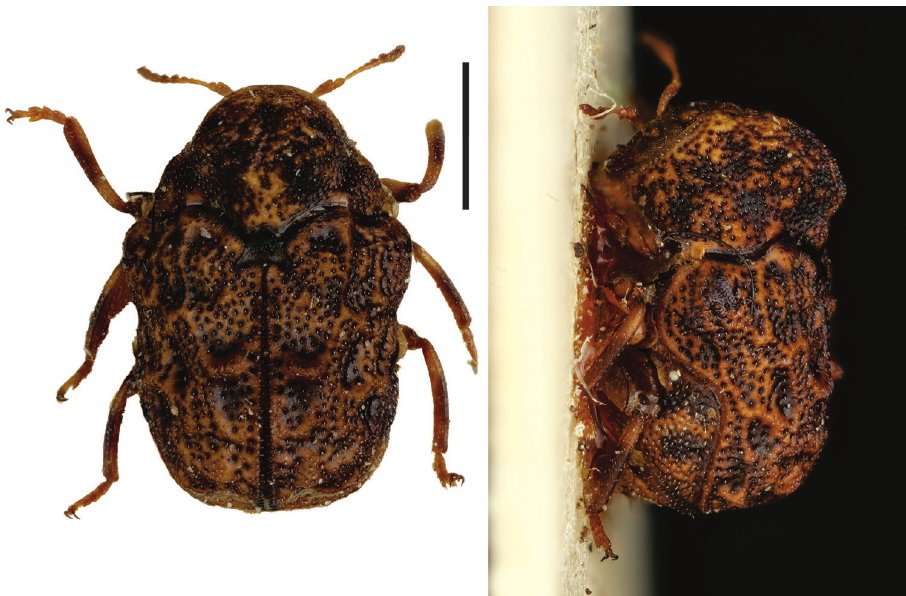
Figure 30. Exema variopicta Monrós (2) , left: habitus (dorsal view), right: habitus (lateral view). 1972; Seeno and Wilcox 1982; Riley et al., 2003). The relationship among Fulcidacini genera remains to be studied.